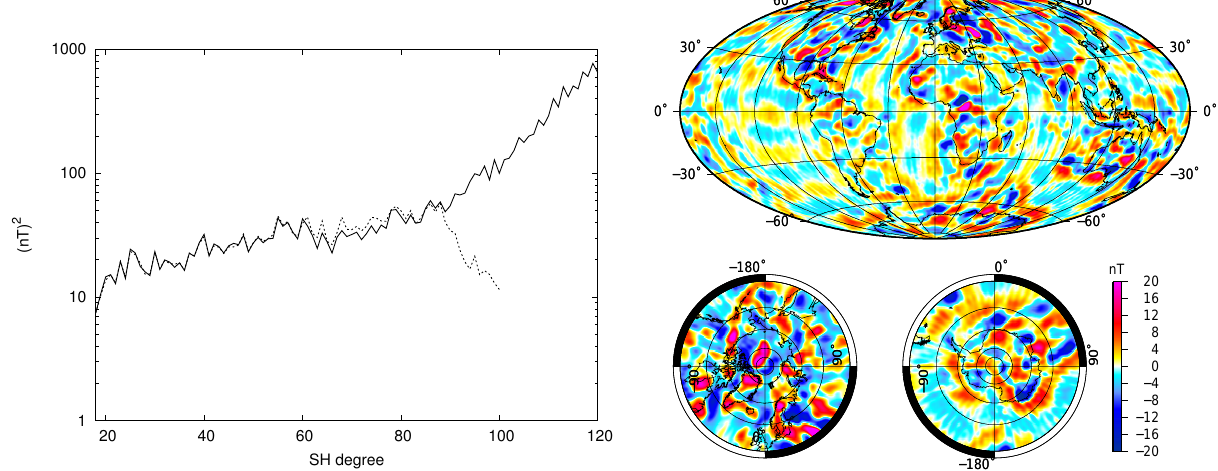
Fig. 4. Left: Power spectra of the lithospheric field model (solid line) and of CHAOS-4b model (dashed line) calculated at the Earth’s surface (i.e. r = 6371 . 2km). Right: Mapping of the vertical down component of the (noisy) lithospheric field ˆ B i at r = 6671 . 2km. The largest magnetic anomalies dominate, but the “along-track” noise is nonetheless visible over oceanic